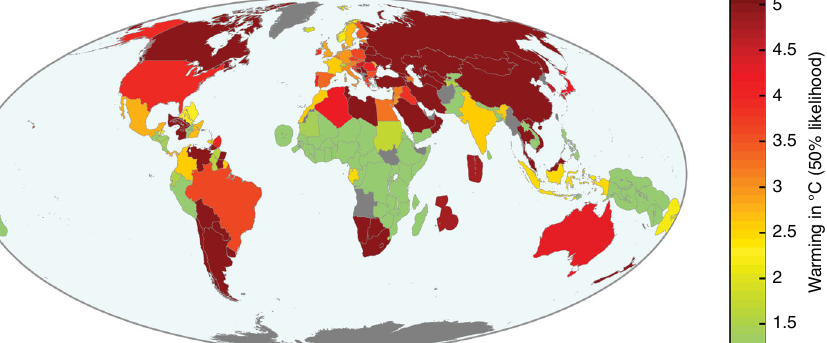
hybrid approach and the 2100-warming of the corresponding global scenario (Methods). Choosing alternative scenarios sub- sets, or alternative representations of the scenario-induced uncertainty range would therefore affect the NDC warming